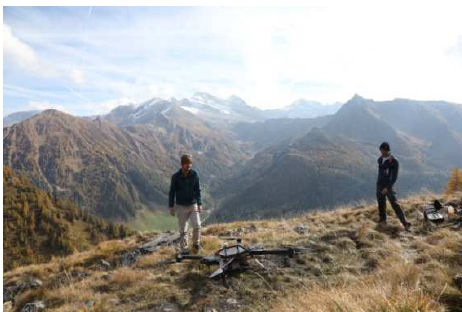
Figure 6. Setting up the system in complex terrain